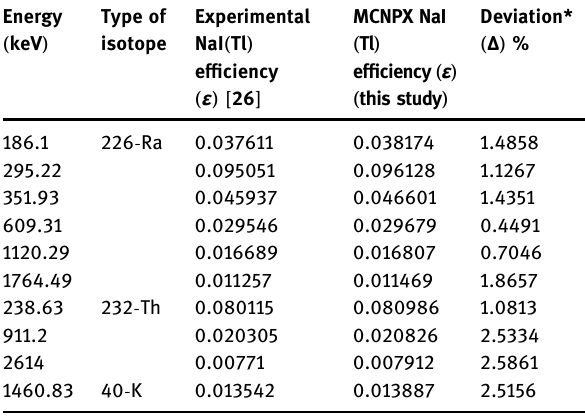
Table 1: Comparison of absolute detection e ffi ciencies and devia - tion ( % ) between experimental and MCNPX results